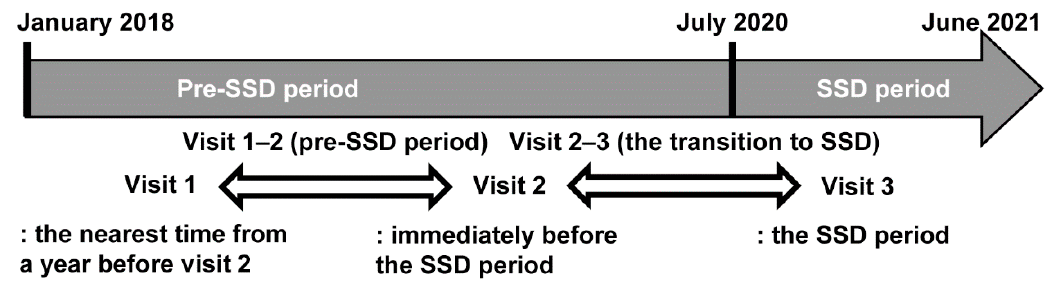
Figure 2. Definition of each visit. SSD, systematic social distancing.